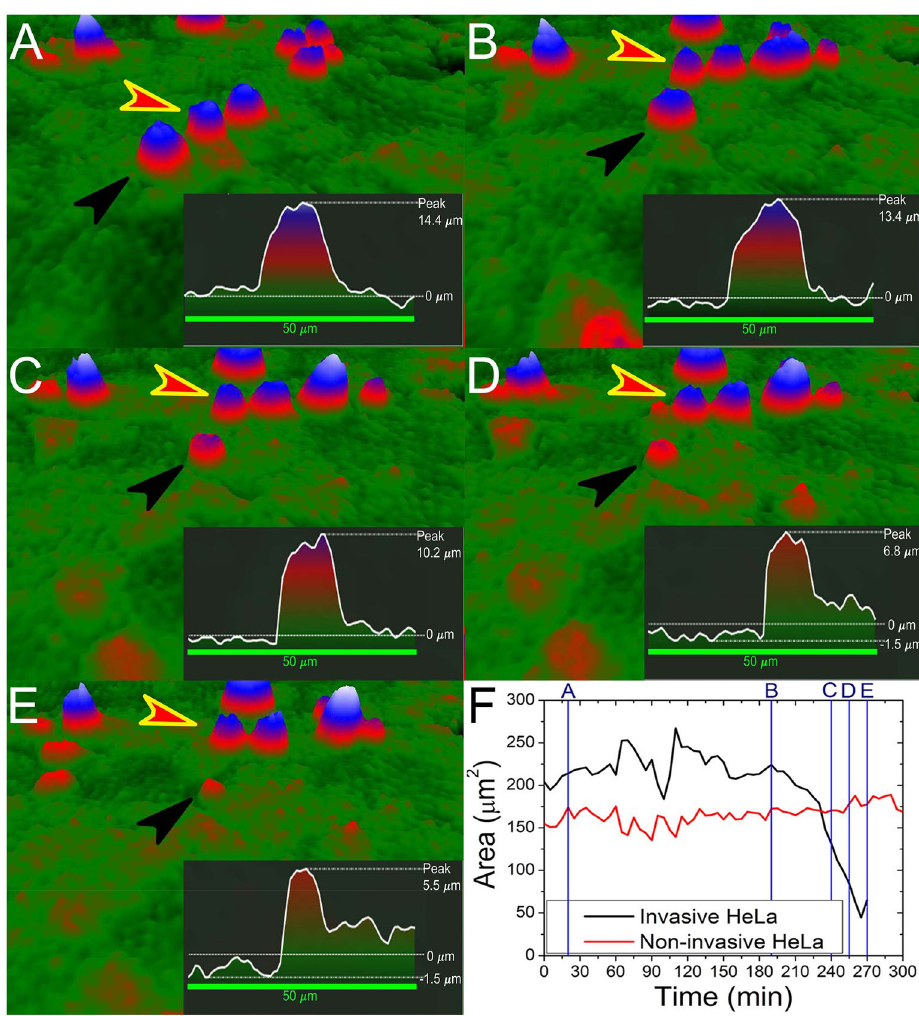
Figure 4. Comparison of invasive and non-invasive HeLa cells. ( A – E ) Black arrowheads indicate the invading, while red arrowheads with yellow outlines indicate the non-invading HeLa cells. A 50 µm length cross-section of the invading cell is present in each picture. Cross-sections show a decrease of the peak value, while the average 0 level is rising, which is the consequence of the infiltration of the cells into the gap. ( F ) Graph of the area over elapsed time since seeding. The drop in the parameter is an indicator of invasion blue lines correspond to the 3D pictures in time to ( A – E ) displaying stages of infiltration: ( A ) 20 min, ( B ) 190 min, ( C ) 240 min, ( D ) 255 min, and ( E ) 270